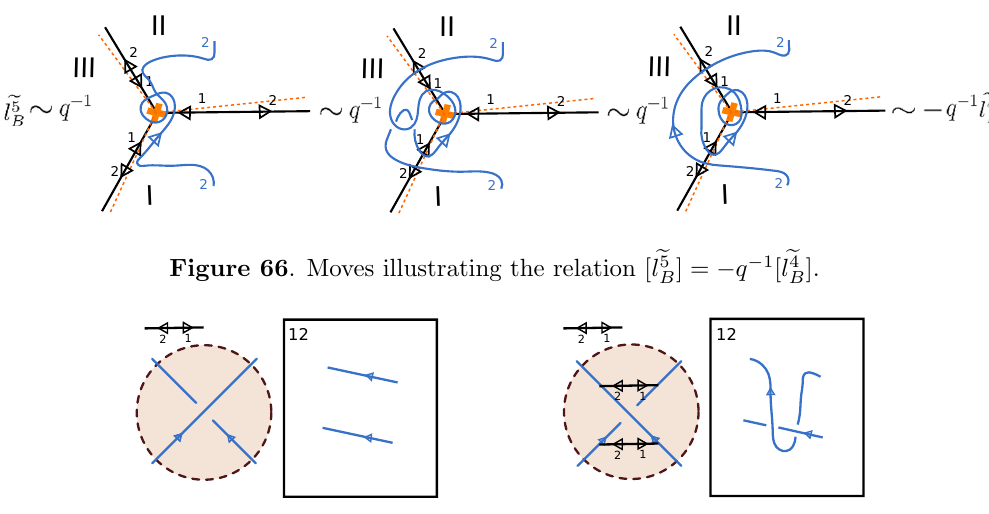
Figure 67 . The two terms on the l.h.s. of skein relation (I) in Sk( M; gl (2)). On the right, we show the loci where exchanges can occur.